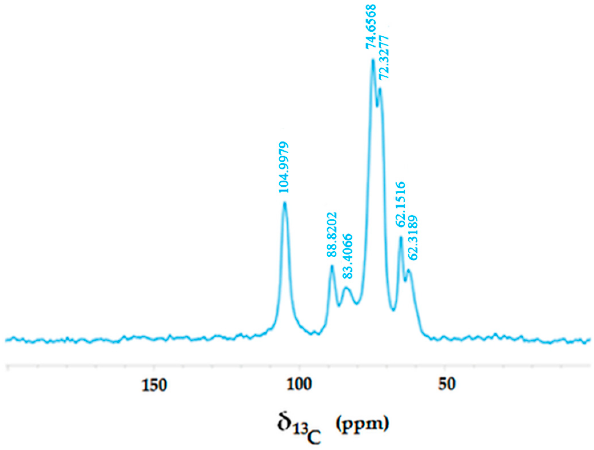
Figure 3. Solid-state Nuclear Magnetic Resonance (NMR) spectrum of untreated hemp fabric.